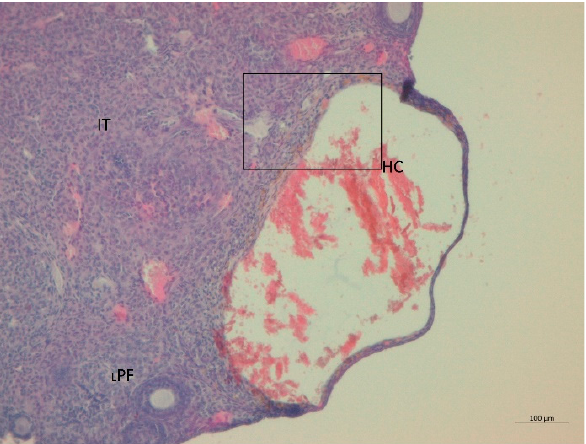
Figure 5. Histological sections of the ovaries with atretic follicles (AF) in intact mice on the HF/HFr diet. TF: tertiary follicle; PF: primary follicle; SF: secondary follicle; CL: corpus luteum; IT: interstitial tissue; O: oocyte; GL: granulosa cells in the process of degradation (H&E; power 100 × ( A )/200 × ( B )).